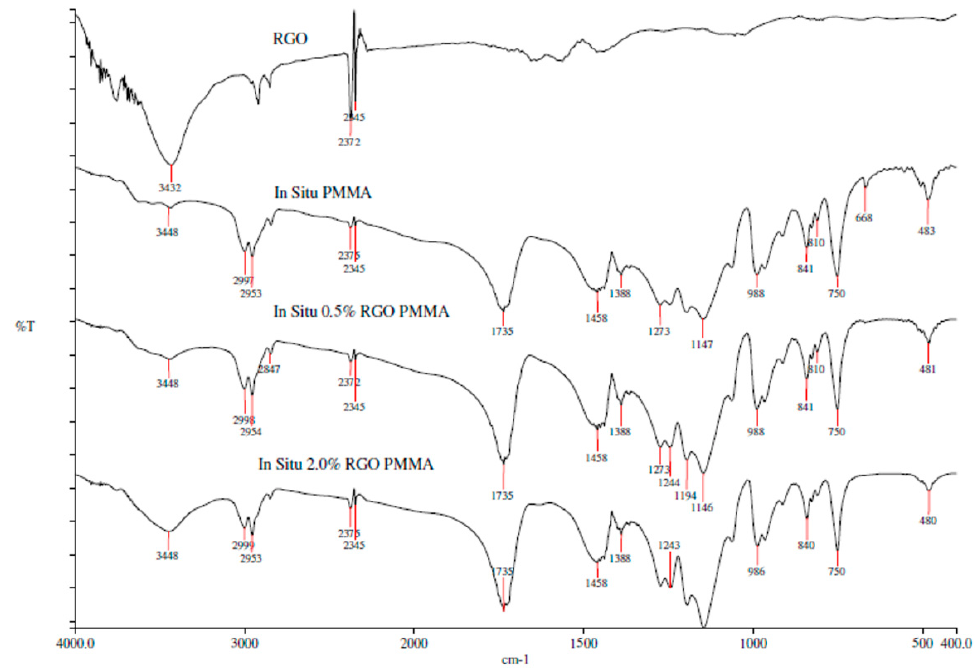
Figure 6. FTIR spectra of RGO, PMMA and nanocomposites prepared by in situ polymerization.